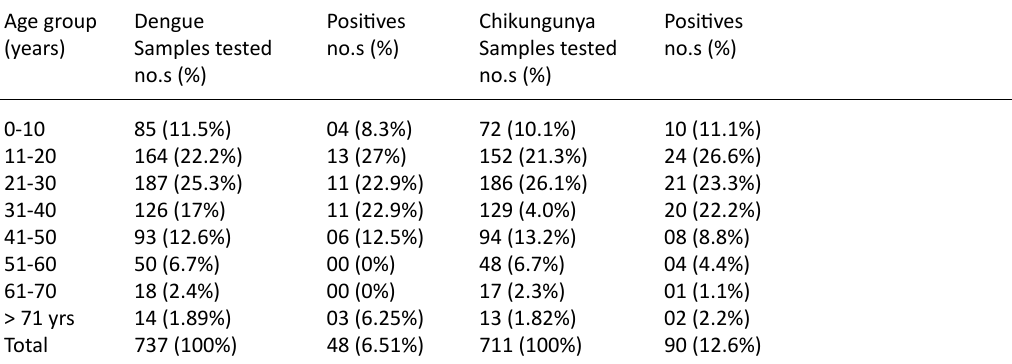
Table 4. Age-wise distribution of Dengue and Chikungunya infection 2018 Age group